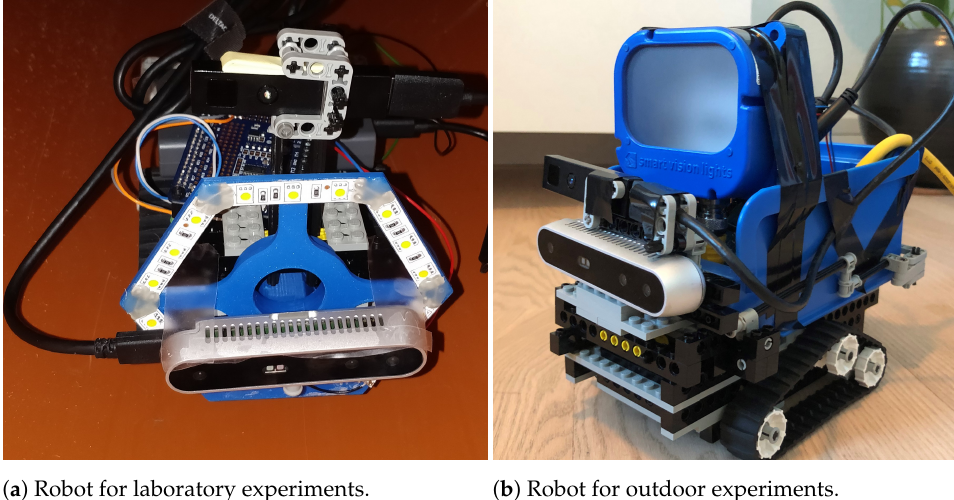
Figure 3. Robotic setup for the laboratory and outdoor experiments. The setup is upgraded for the outdoor experiments with a new light source and a blue box that protects the Raspberry Pi from